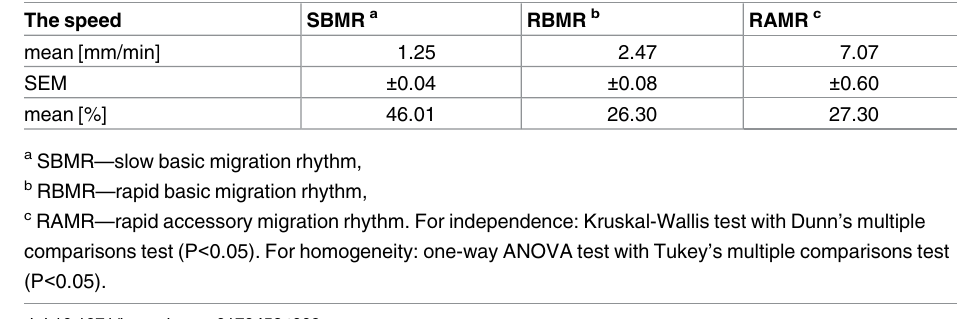
Table 3. The values (mean ± SEM) and the percentage (mean %) of bursts propagation speed along the uterus in relation to the total number of highly synchronized uterine contraction